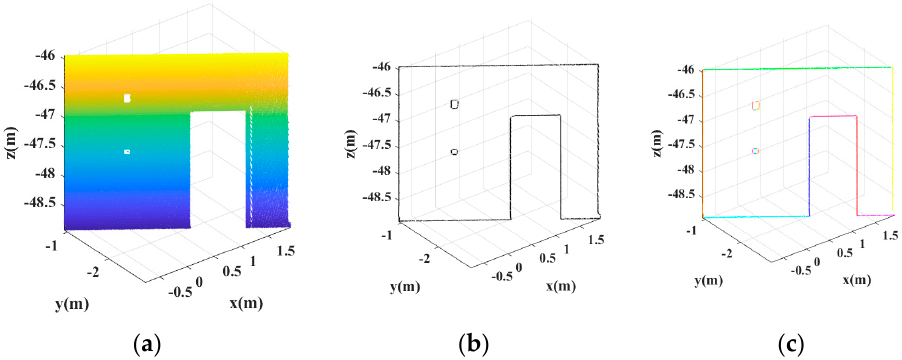
Figure 10. A demonstration of extracting 3D line segment from planar point cloud. ( a ) Planar point cloud. ( b ) Extracted contour points. ( c ) Extracted 3D line segments.